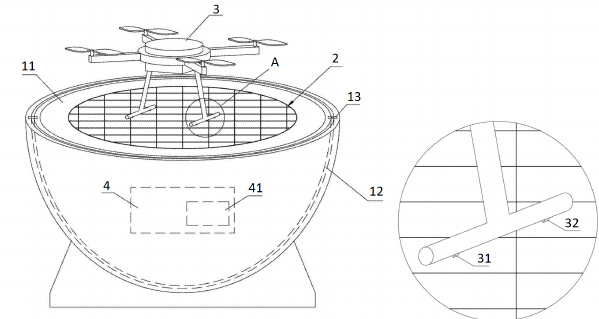
Figure 4. Automatic contact-type UAV charger on a landing station [35]. 2, landing surface with electric contacts; 3, UAV; 4, charging controller; 31, 32, electric contacts on UAV